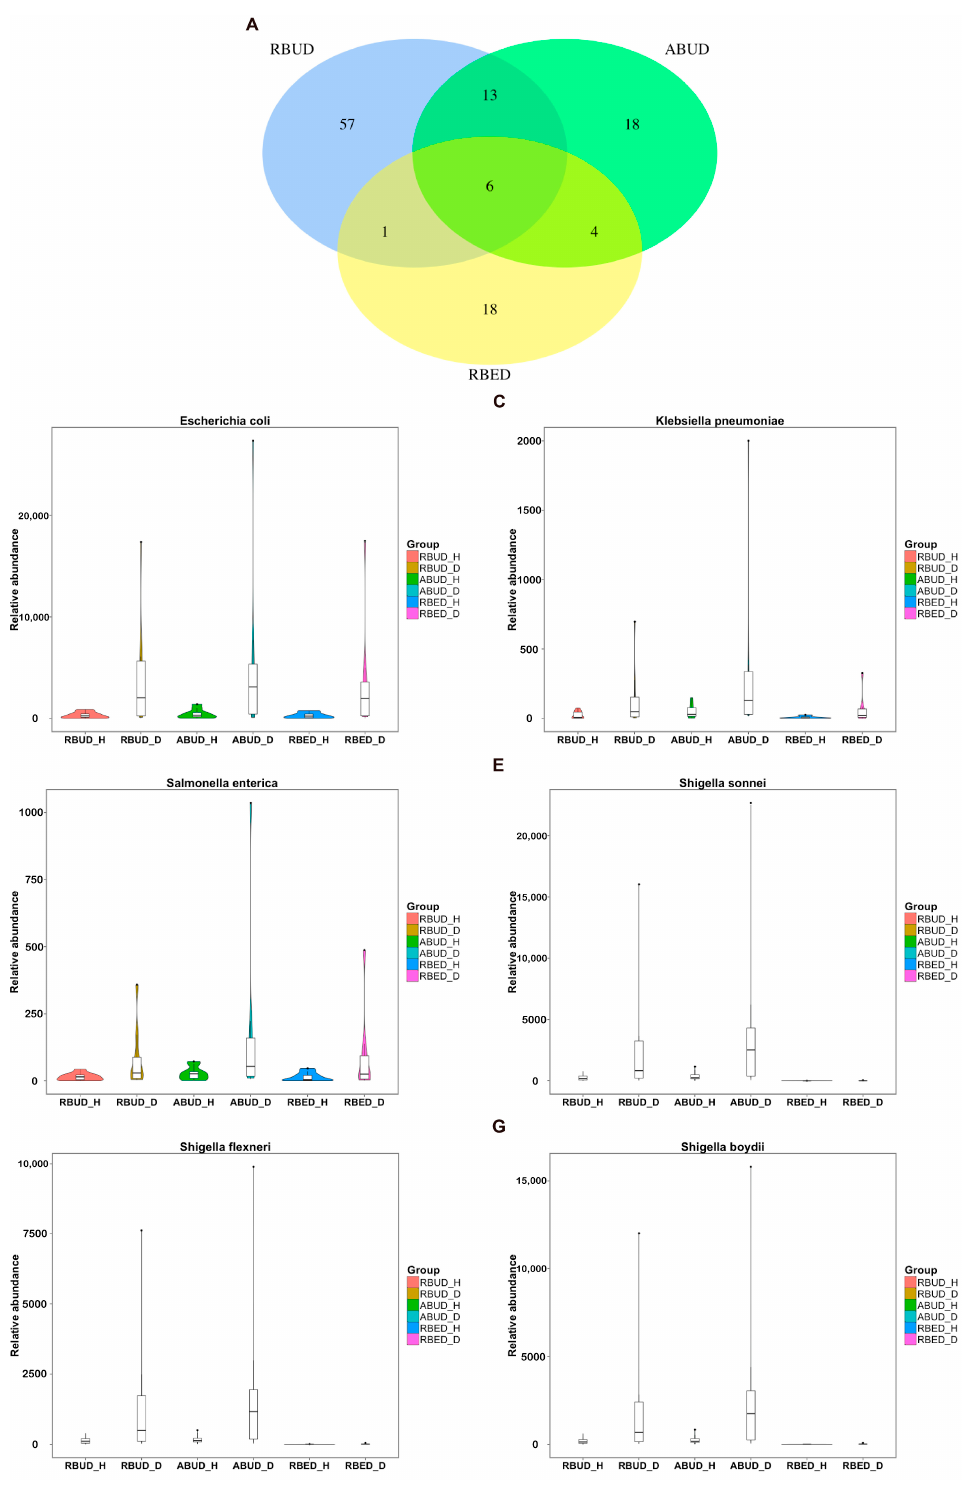
Figure 6. The relative abundance changes of the common gut microbiota detected by the three methods. ( A ) Venn Diagram showed the specific or the common differential microbial species obtained by the three methods in healthy and disease samples. ( B ) The abundance change of Escherichia coli between healthy and disease groups. ( C ) The abundance change of Klebsiella pneumonia . ( D ) The abundance change of Salmonella enterica . ( E ) The abundance change of Shigella sonnei . ( F ) The abundance change of Shigella flexneri . ( G ) The abundance change of Shigella boydii .